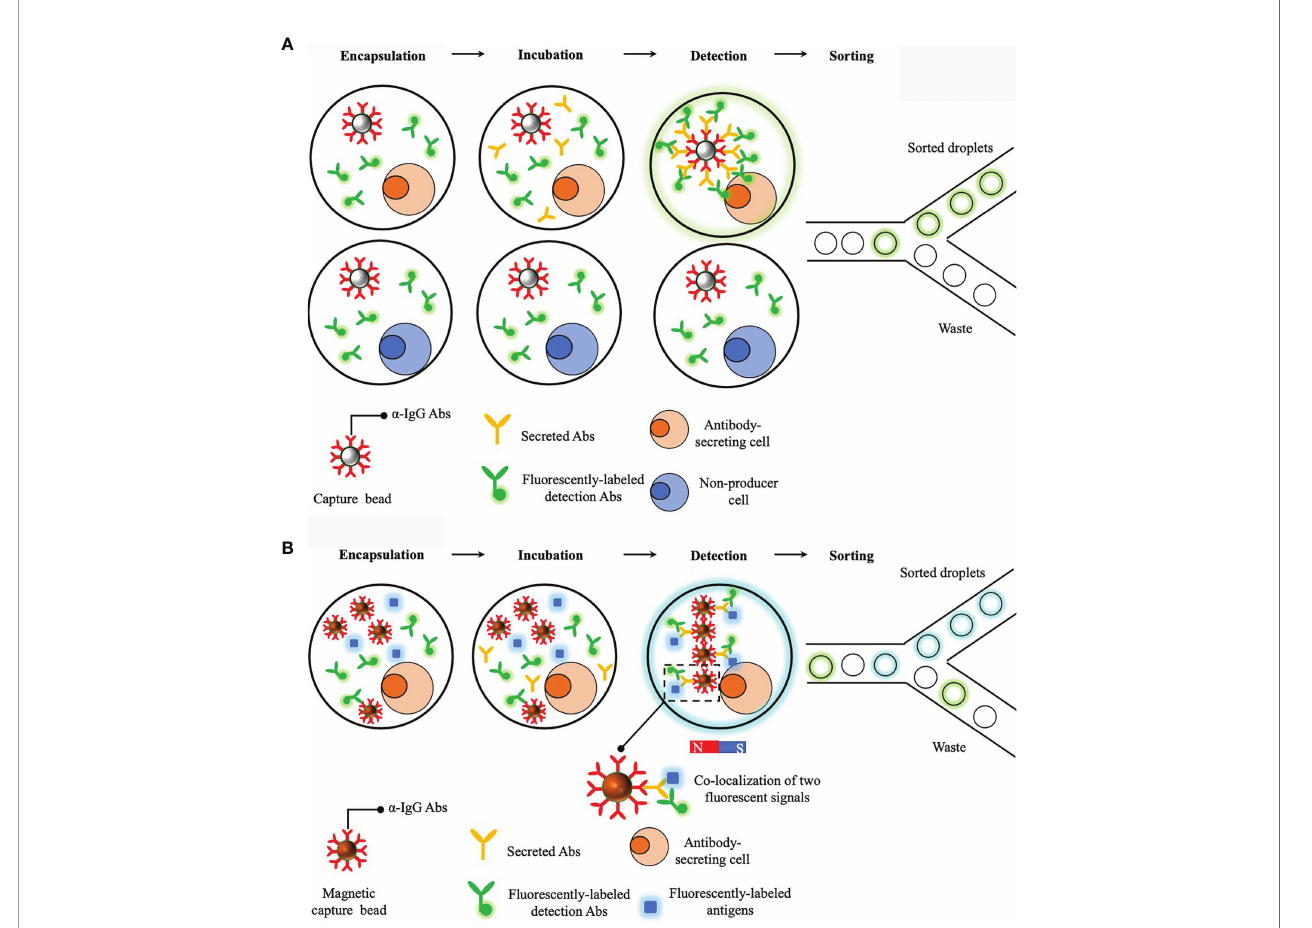
FIGURE 3 | Droplet-based micro fl uidics platforms for single cell antibodies secretion measurements. (A) Sorting of antibody-secreting cells. Secreted antibodies were captured on the bead together with fl uorescently-labeled detection antibodies. This leads to a localization of fl uorescent signals on the bead and fl uorescent droplets can then be sorted. (B) Dropmap platform for studying antibody secretion and af fi nity to cognate antigens. Compared to the previous platform, a major improvement of Dropmap is the encapsulation of magnetic beads and fl uorescently-labeled antigens within each droplets. After antibody secretion, a magnetic fi eld is applied to induce the formation of elongated and easily observable bead aggregates line, termed beadline. This helps amplify fl uorescent signals and therefore, increase the sensitivity. Normally there are three scenarios after incubation, the fi rst one is no fl uorescent signal is observed and this indicates the cell is not able to secret antibodies; the second scenario is that only fl uorescent signals from detection antibodies is localized on magnetic beads and this indicates the cell is able to secret antibodies but with poor speci fi city and af fi nity to cognate antigens; lastly, co-localization of two fl uorescent signals is observed and this indicates cell is able to secret antibodies with desired speci fi city and af fi nity to cognate